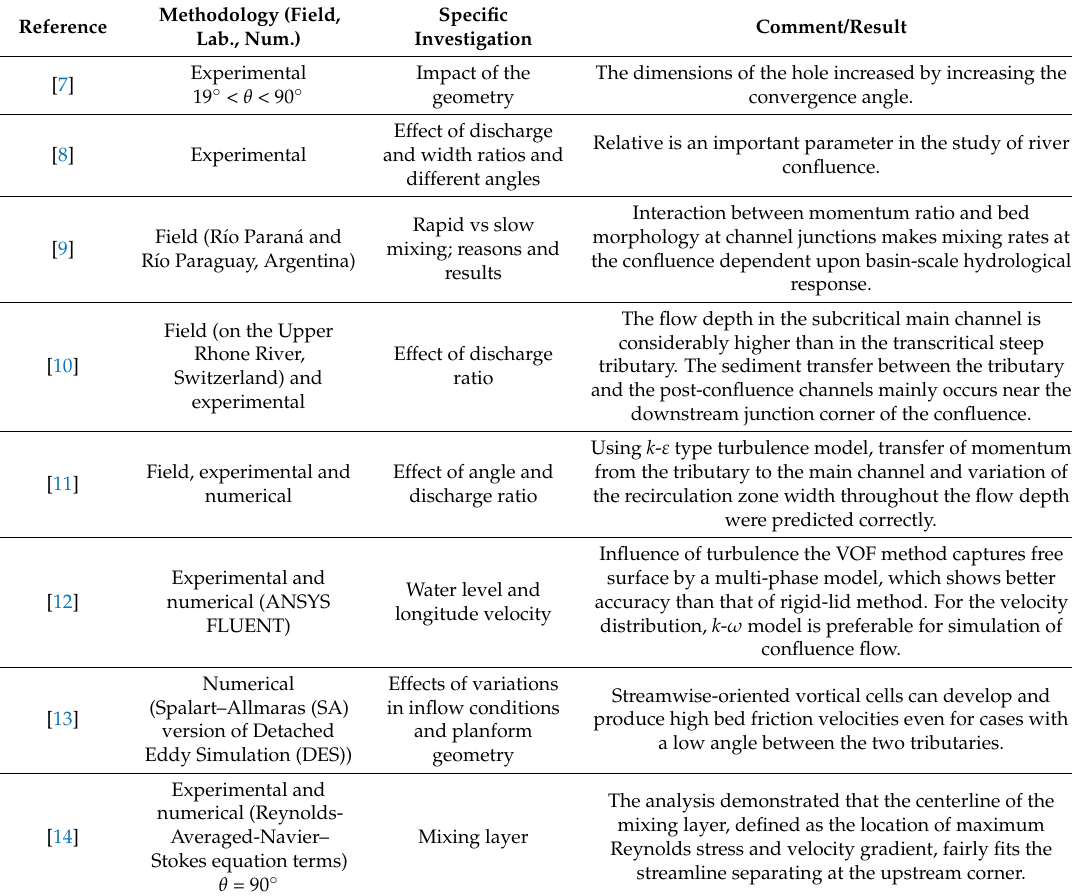
Table 1. Review of some recent studies on confluence hydrodynamics and morphodynamics.